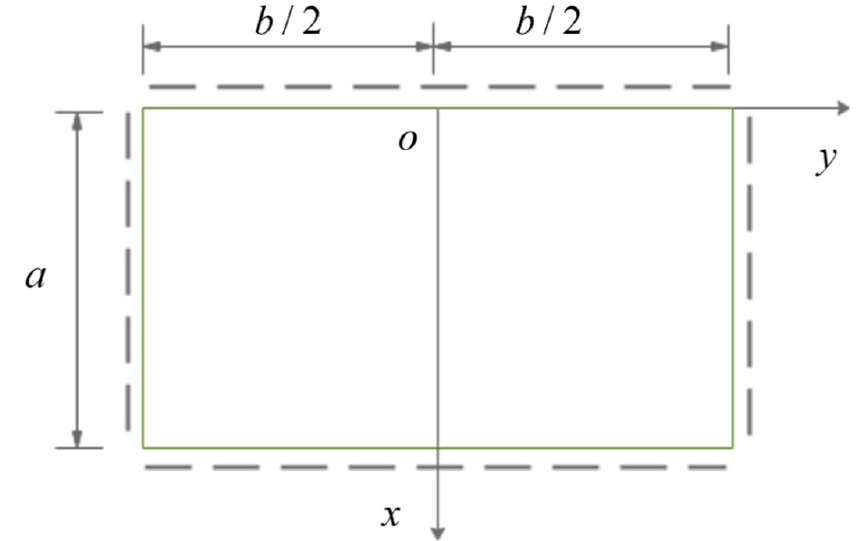
Figure 2. A thin piezoelectric plate with full edges simply supported.